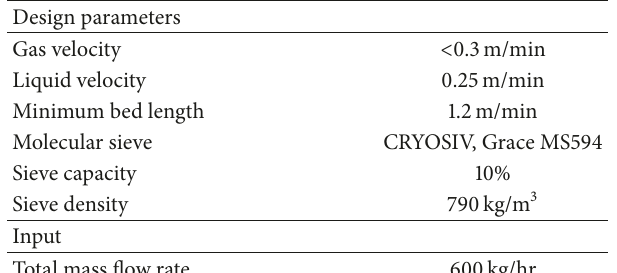
Table 4: Technical data of the adsorbent columns CD1 and CD2 of Figure 2.